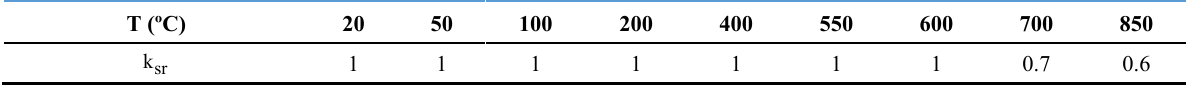
Table 3. Reduction factor for residual strength of